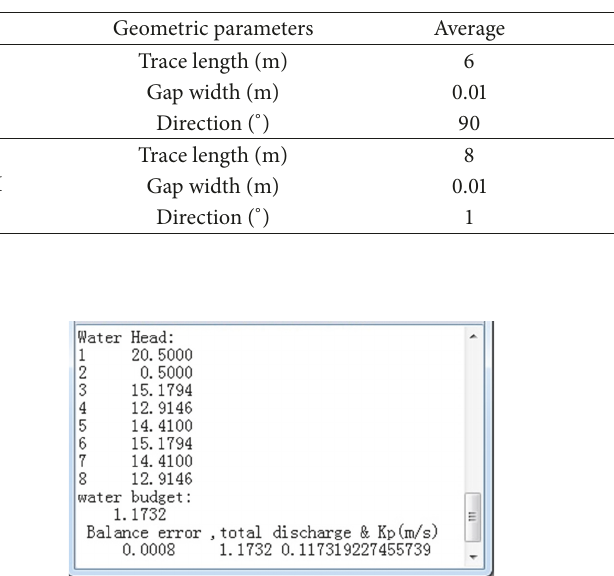
Table 1: Input data of the simulation fractures.